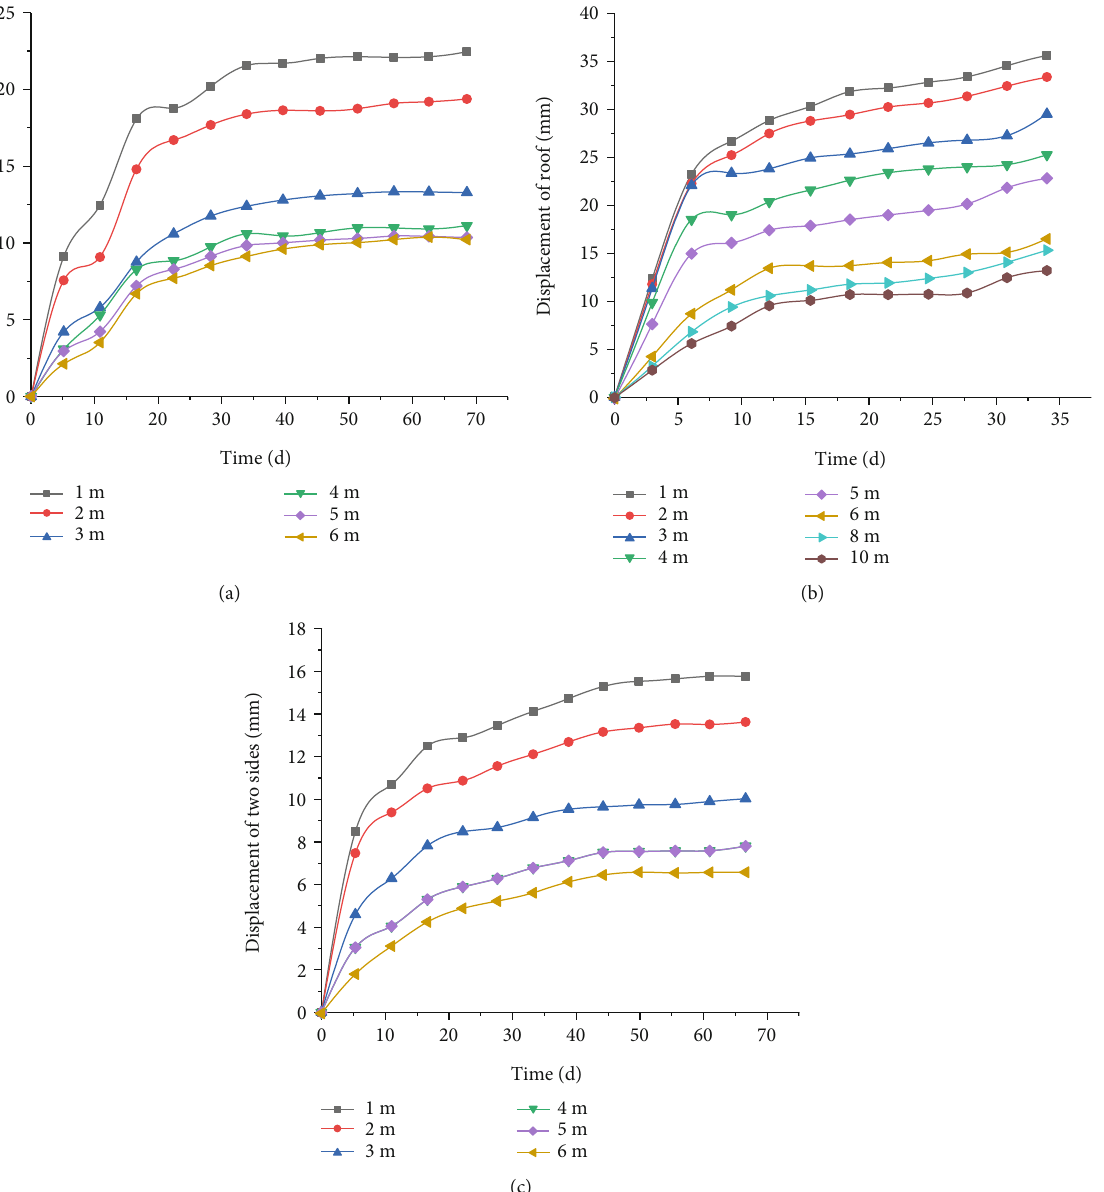
Figure 14: Displacement curve of surrounding rock of roadway in improved